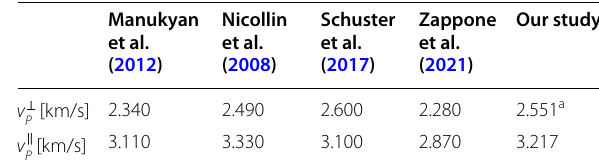
Table 2 Comparison of P-wave velocities from the anisotropic characterization (Table 1) with other experiments for the shaly